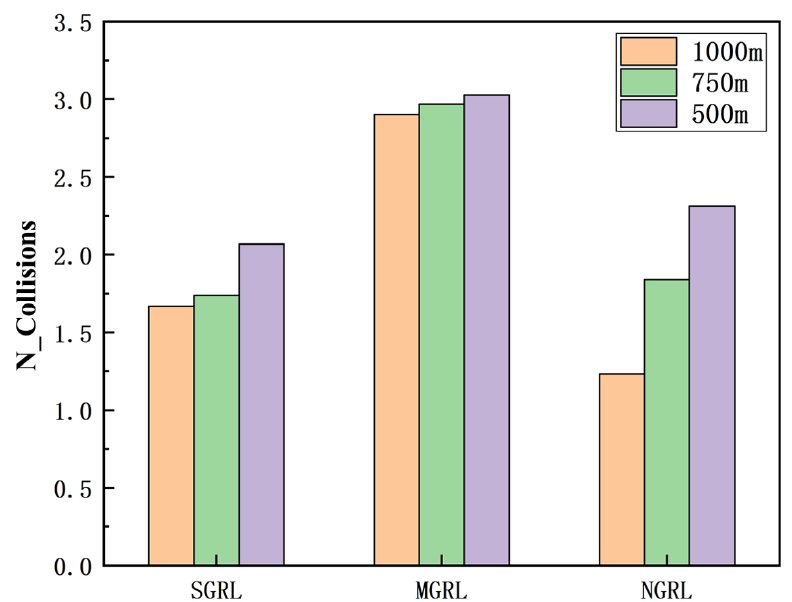
Figure 23. Diagram of testing collisions. This value is the number of collisions between vehicles obtained by real-time detection in the simulation scenario.